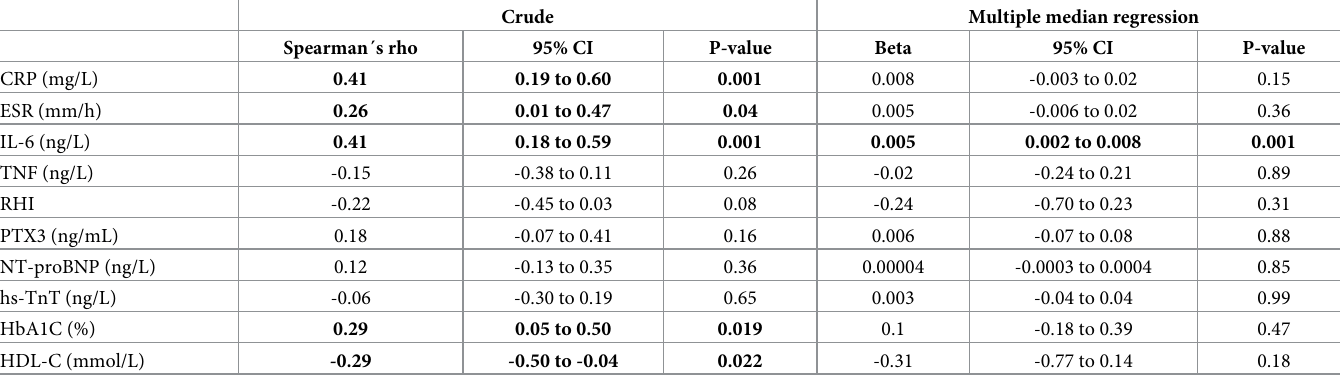
Table 3. Associations between TCC levels and selected variables at baseline. Crude Multiple median